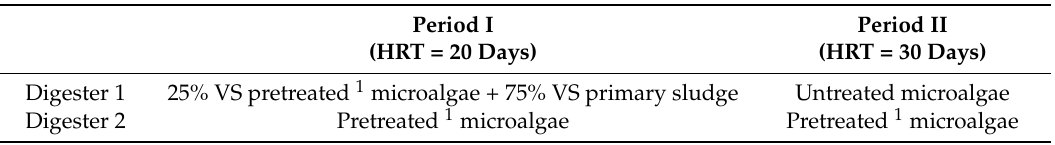
Table 1. Experimental conditions during the mesophilic anaerobic digestion (AD) in lab-scale reactors. HRT: hydraulic retention time; VS: volatile